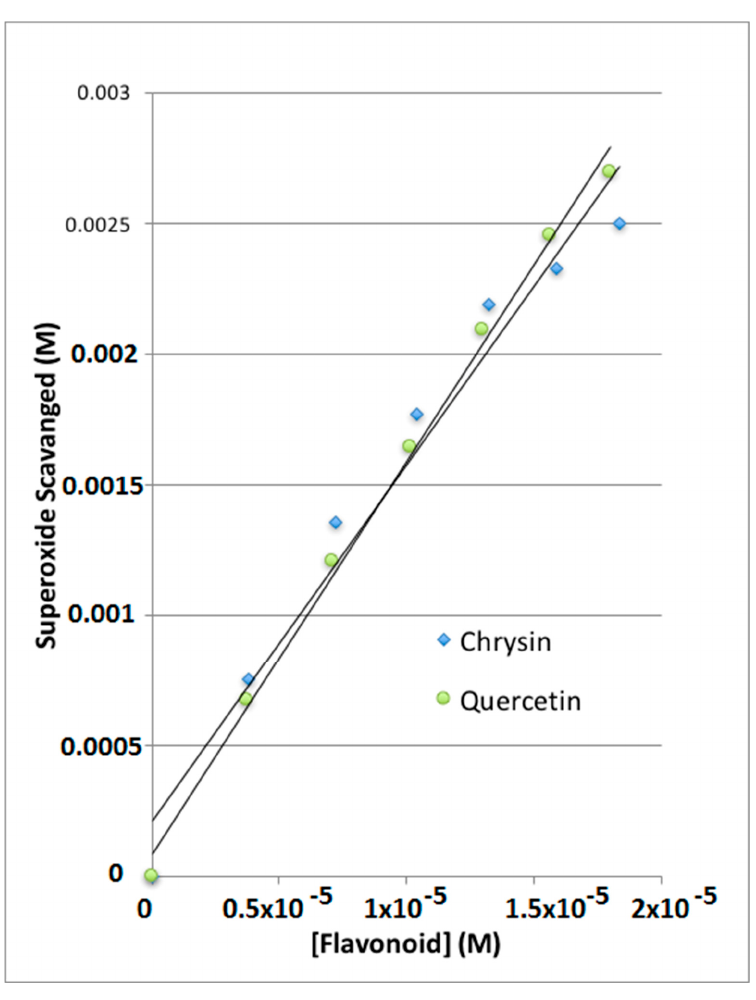
Figure 8 . Superoxide scavenging by chrysin and quercetin. Figure 8. Superoxide scavenging by chrysin and quercetin.